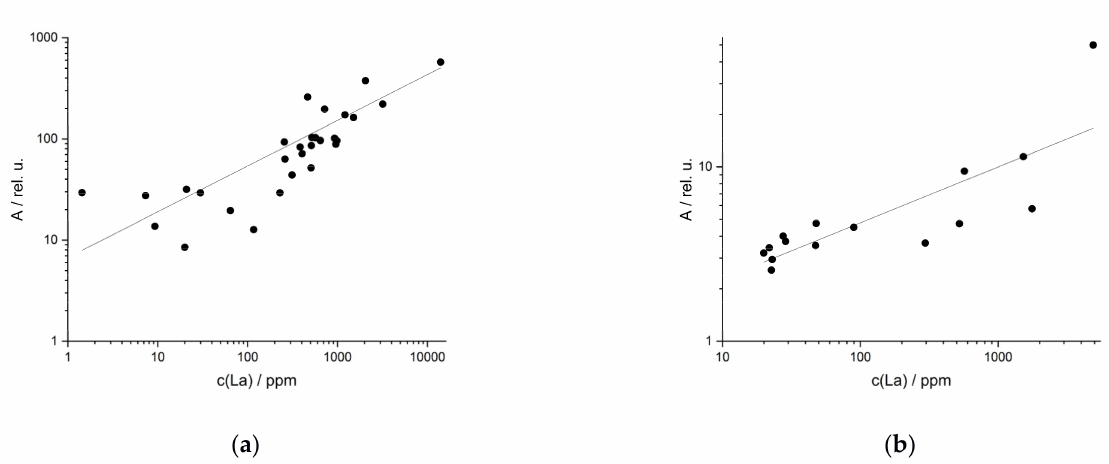
Figure 6. Univariate regression of field samples ( a ) in rocks from La (R 2 (408.67 nm) = 0.82) and ( b ) in soils from La (R 2 (404.29 nm) =